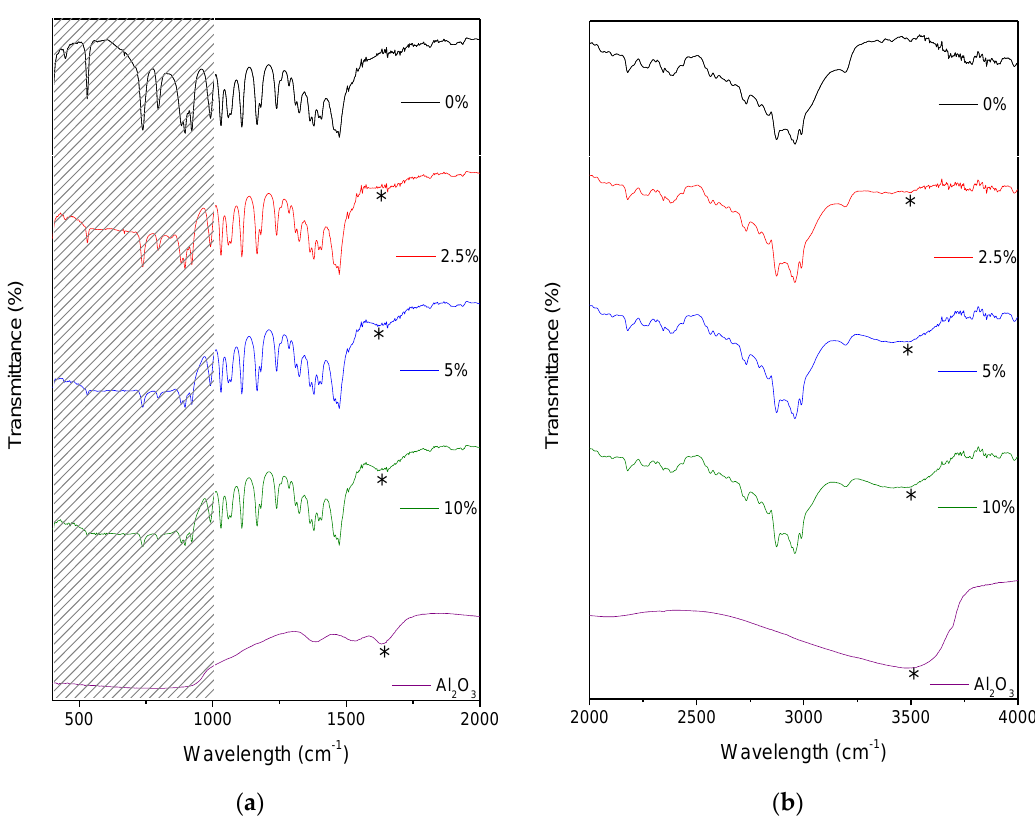
Figure 2. IR spectra obtained for TBA-Br+Al 2 O 3 additive in range of ( a ) 400–2000 cm −1 and ( b ) 2000–4000 cm −1 , and the Al 2 O 3 additive.